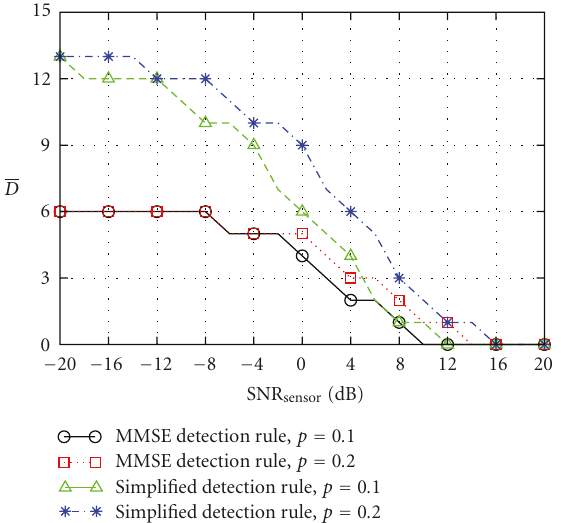
Figure 5: Distance, as a function of the sensor SNR, in a scenario with N = 8 sensors and absence of quantization. Two di ff erent values of the equivalent bit error rate p (corresponding to di ff erent according to (12)) are considered: (i) 0.1 and (ii) values of σ 2 comm 0.2. Both MMSE and simplified detection algorithms at the AP are considered.